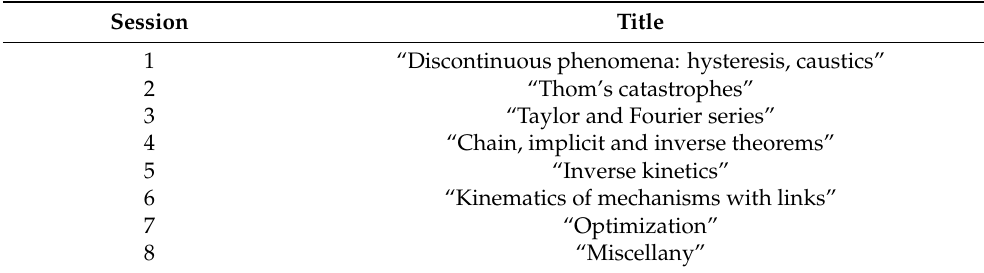
Table 1. Applications of Multivariable Calculus in